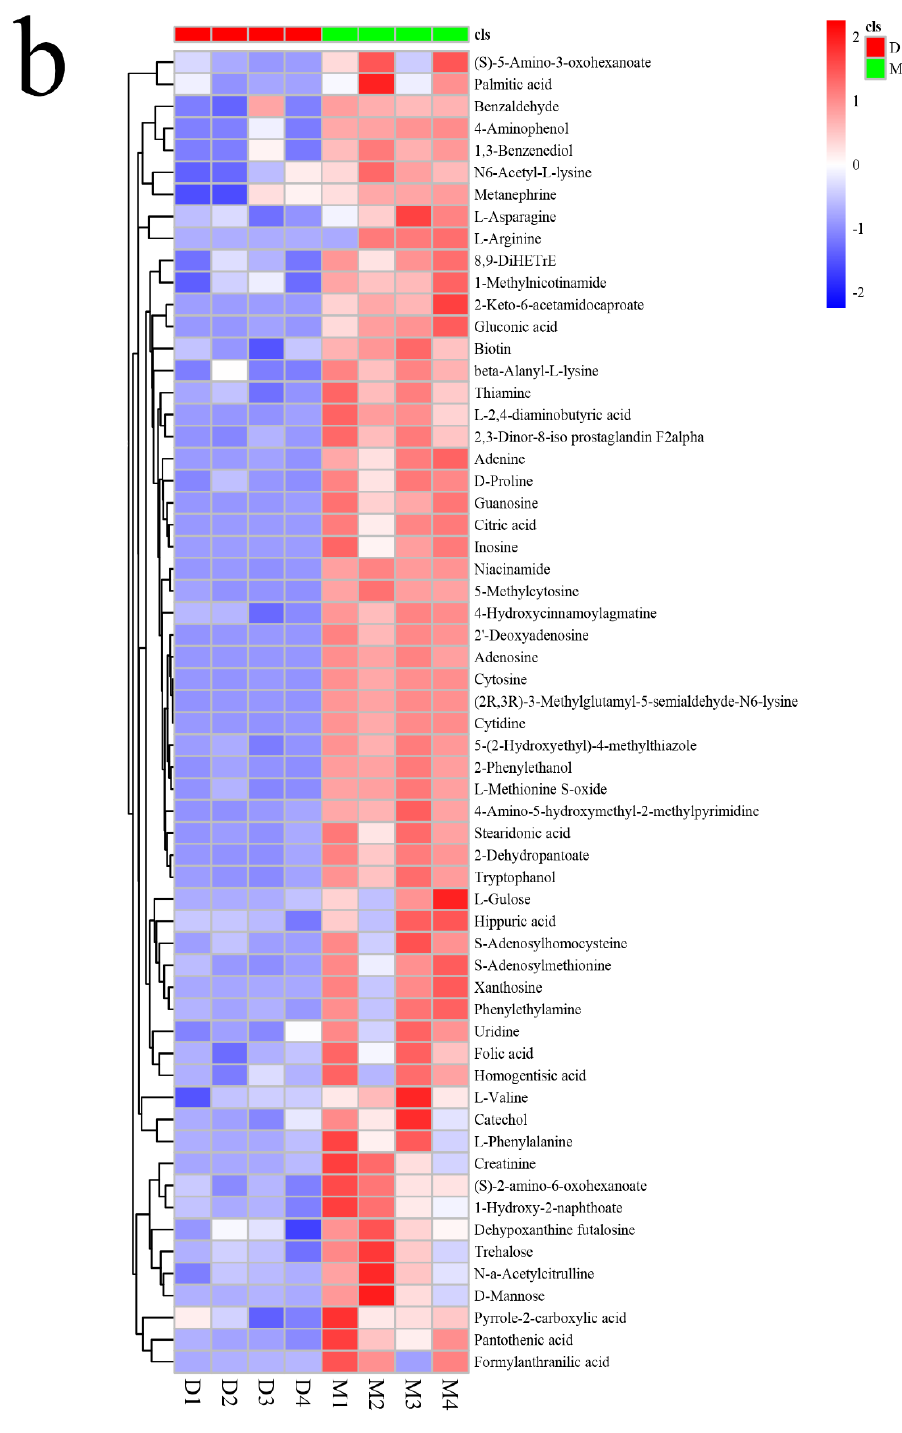
Figure 5. A heat map of L. fermentum RC4 differential metabolites ( a , b ). Note—D: Experimental group; M: MRS broth group. The magnitude of the relative content in the graph is shown by the different colors: red represents high sample content, blue represents low sample content, and the darker the color, the higher or lower the relative content. The columns represent sample groups and the rows represent metabolites. Both fermentation broth and culture broth groups were divided into four replicates: D1, D2, D3, and D4, and M1, M2, M3, and M4, respectively. Two metabolite groups were clustered within the group, and the metabolic patterns or metabolic pathways were distinct between the groups.